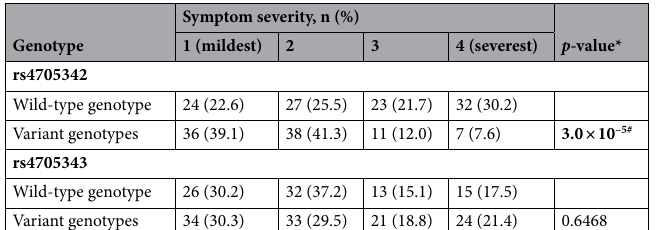
Table 5. Association of miR-145 SNPs with the symptoms severity among asthmatic patients. *Chi-square without Yate’s correction test. # Statistically significant.